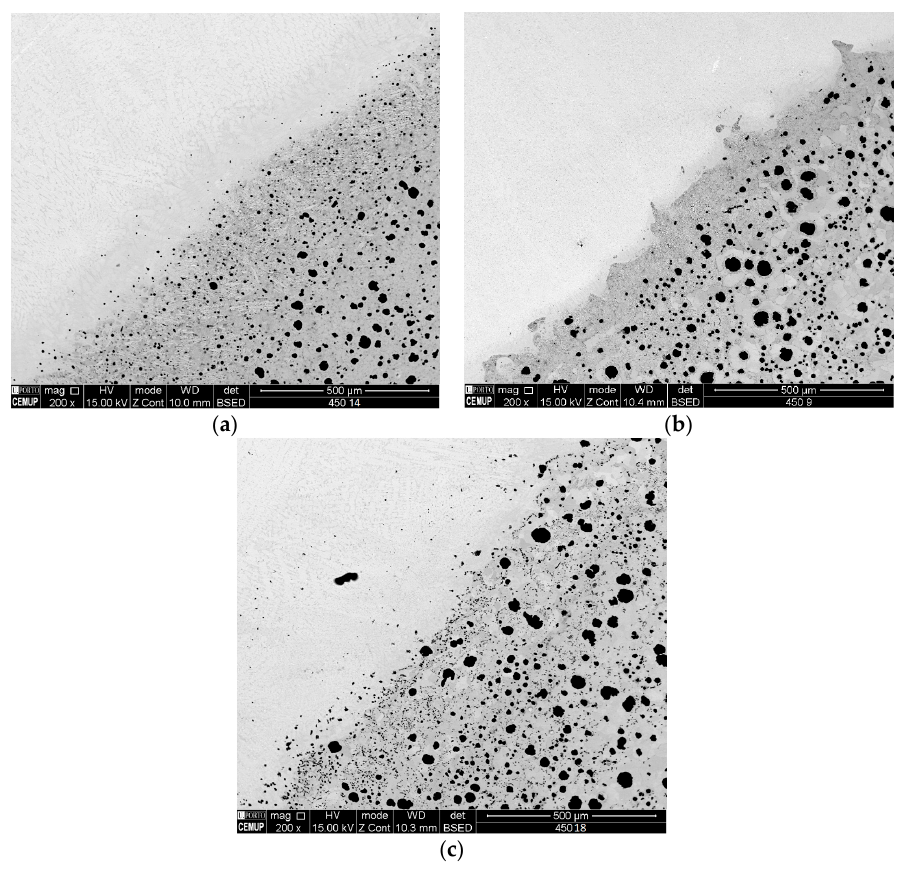
Figure 10. SEM (Scanning Electron Microscopy) analysis of samples at 200× magnification with 4% Nital